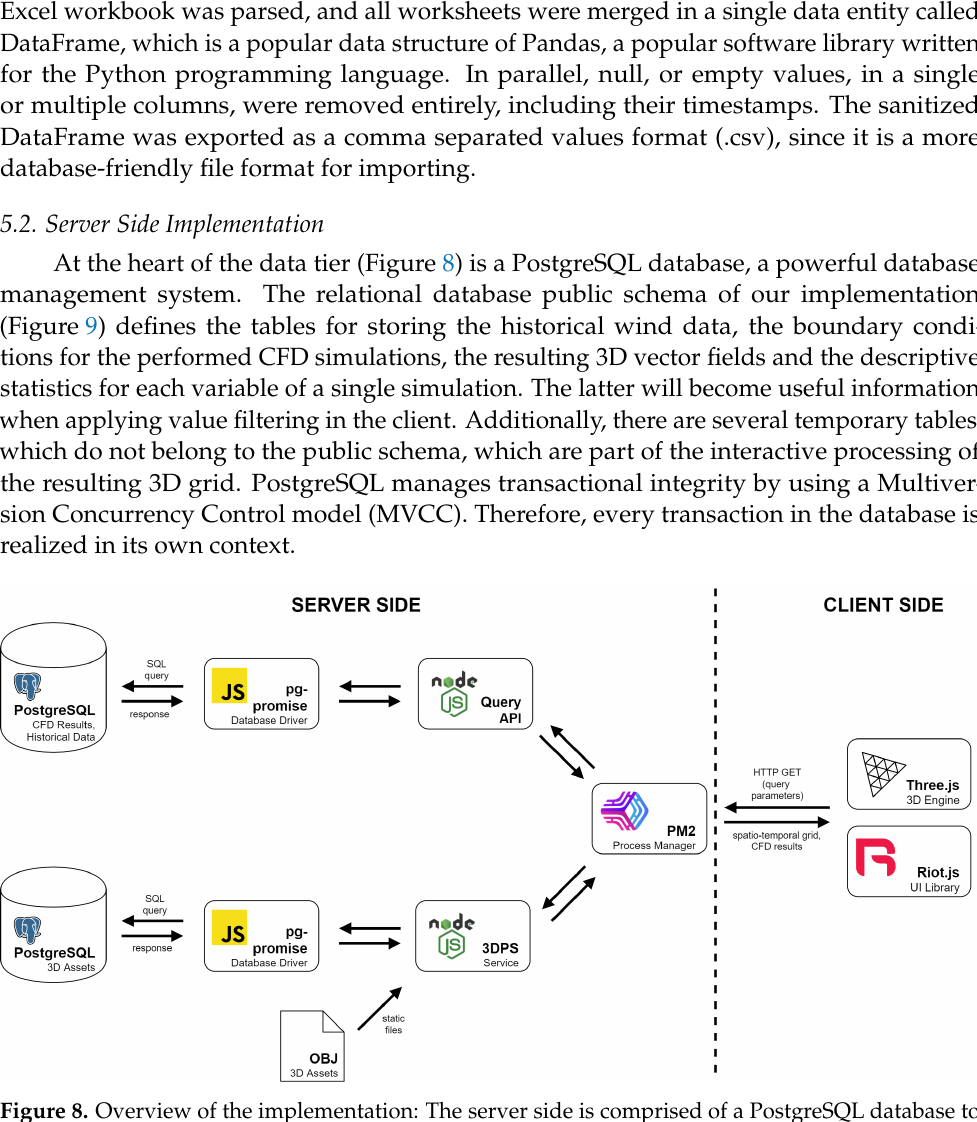
Figure 8. Overview of the implementation: The server side is comprised of a PostgreSQL database to host the CFD and historical data. Both services, 3DPS and Query API, are implemented in Node.js. 3DPS implementation allows dynamic 3D assets fetching hosted in a relational database and static 3D assets stored in the